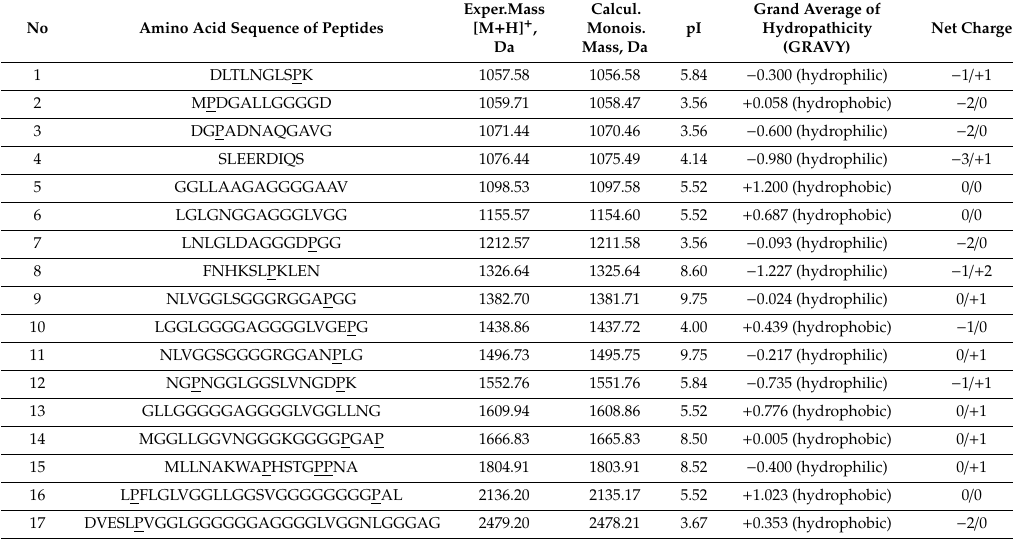
Table 1. Amino acid sequences of peptides from mucus of the garden snail C. aspersum , identified by de novo sequencing on MALDI-MS /